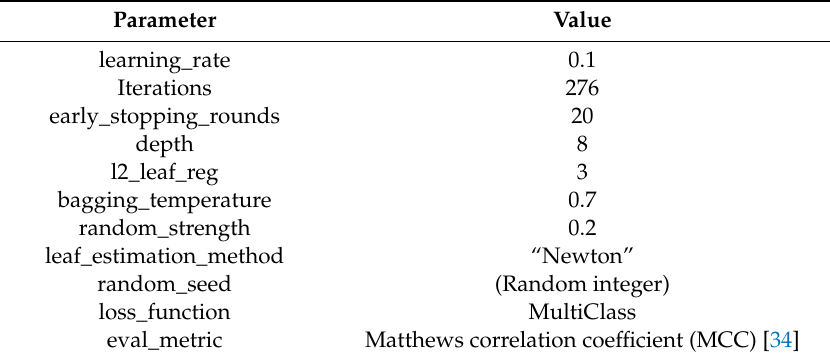
Table 3. Parameters for training the CatBoost model.